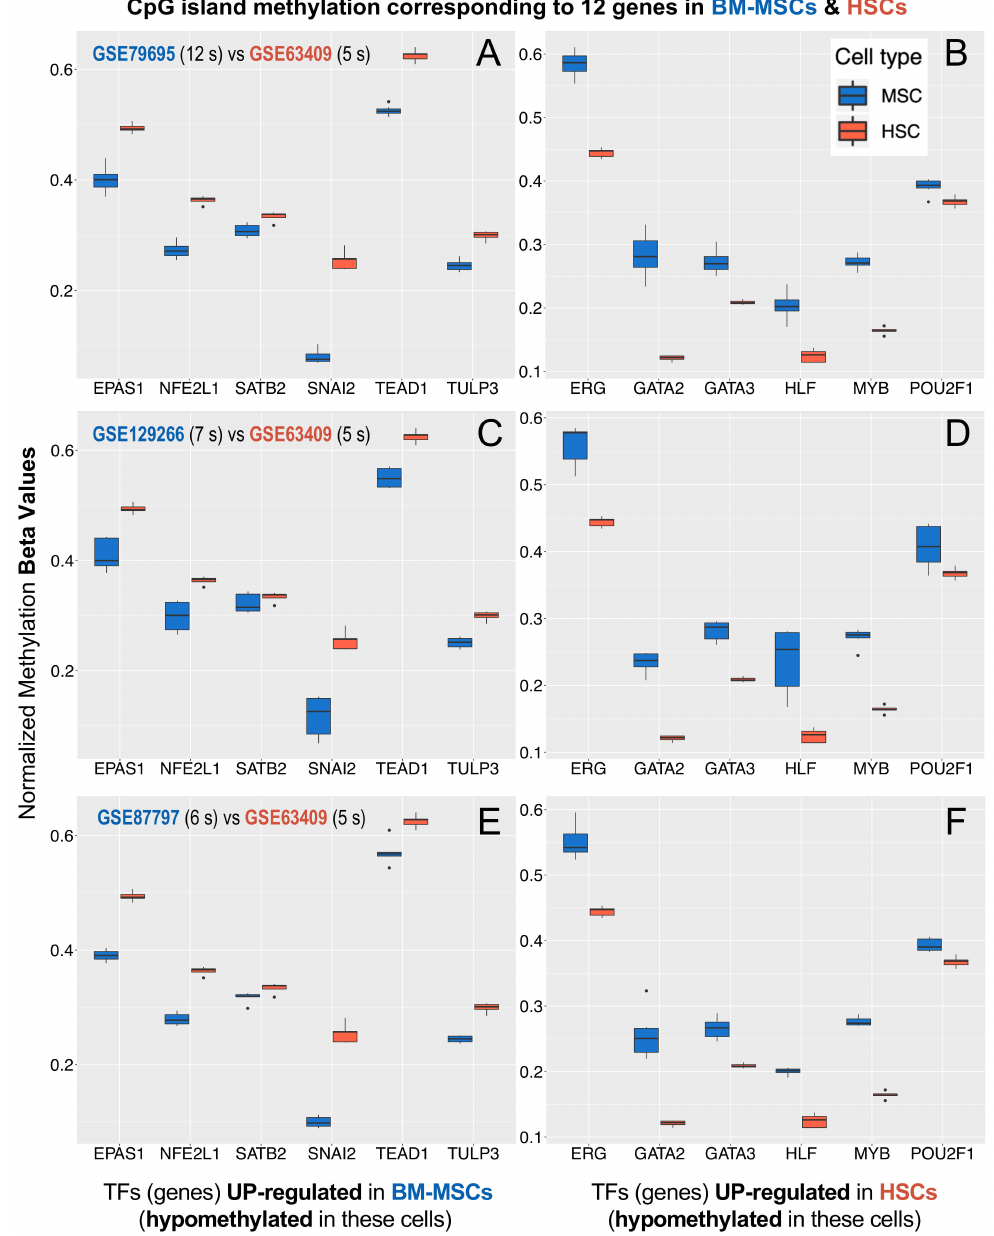
Figure 3. DNA methylation levels (measured as Beta values) of 12 TFs (blue boxplots) in 3 independent datasets of BM-MSCs ( A , C , E ) (GSE79695, GSE129266, GSE87797) in comparison with the methylation levels of the same TFs (red boxplots) in a dataset of HSCs ( B , D , F ) (GSE63409) (s indicates the number of samples). The TFs represented are: EPAS1, NFE2L1, SATB2, SNAI2, TEAD1, TULP3 hypomethylated in BM-MSCs; and ERG, GATA2, GATA3, HLF, MYB, POU2F1